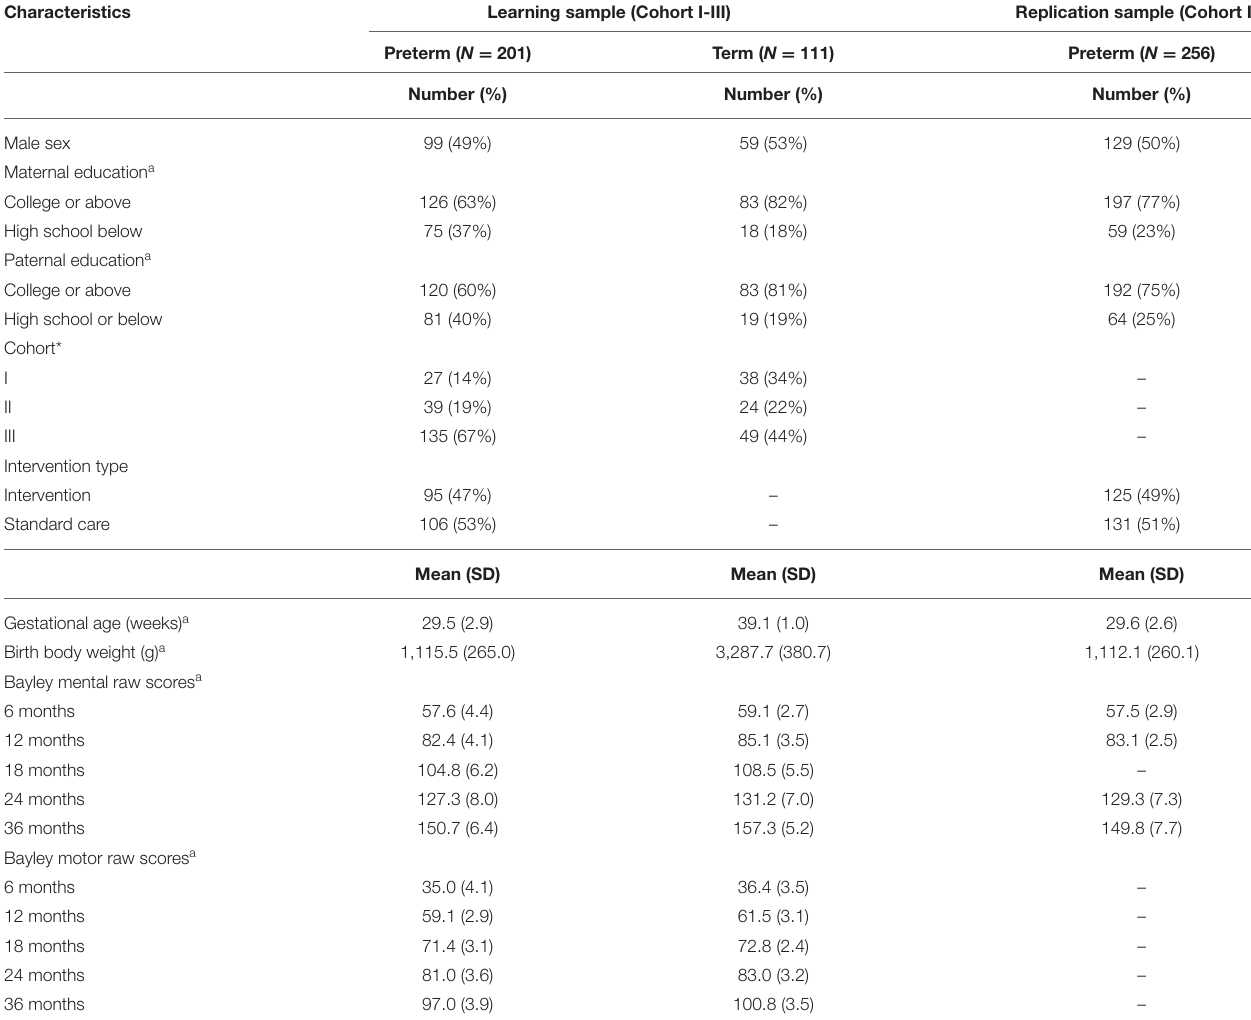
TABLE 1 | Birth and demographic characteristics of preterm and term children.